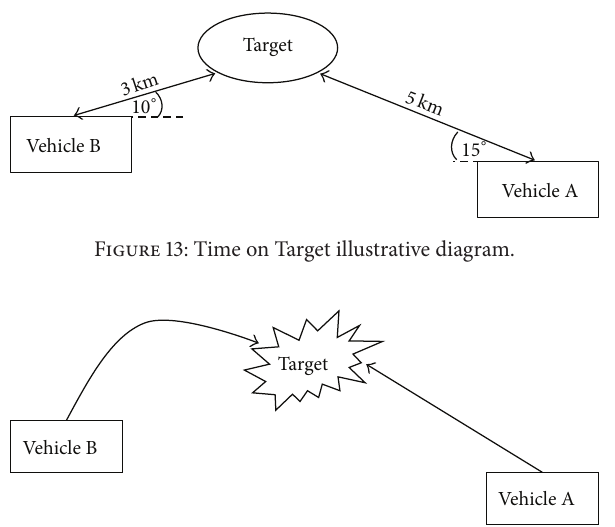
Figure 14: Time on Target attack diagram.